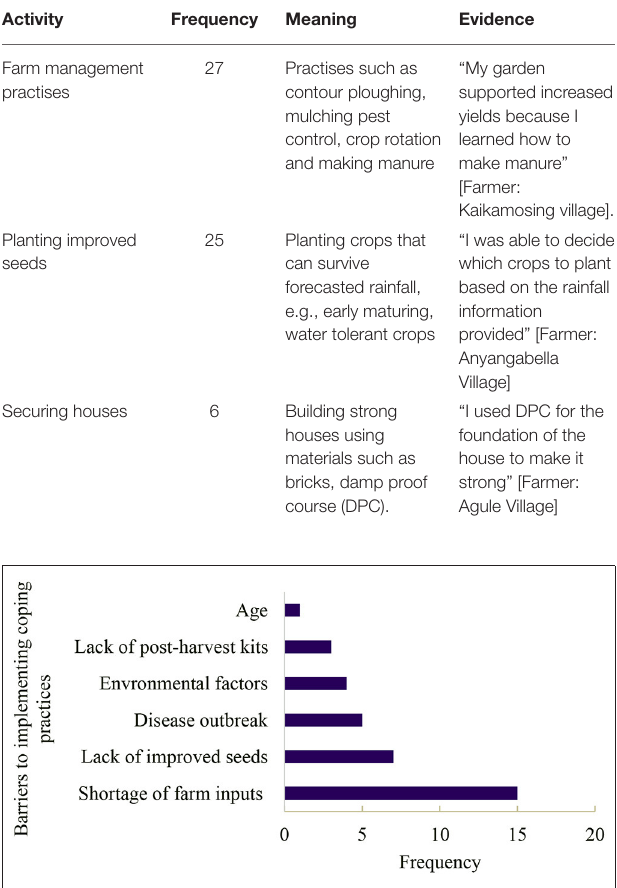
FIGURE 5 | Barriers to implementing coping practises across the three villages (Anyangabella, Kaikamosing, and Agule) in Katakwi District,